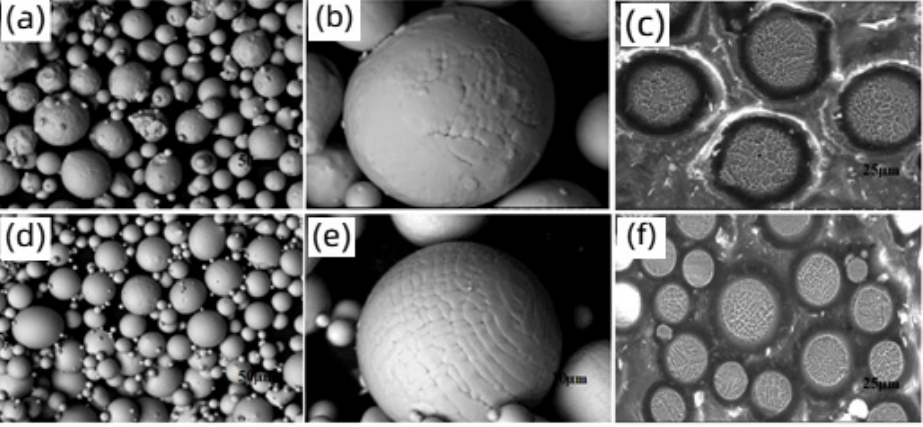
Figure 2. BSE image and etched crossection at 500×, 2500× and 1000× magnification of G.A powder ( a – c ) and C.A powder ( d – f ). ( a – c ) and C.A powder ( d – f